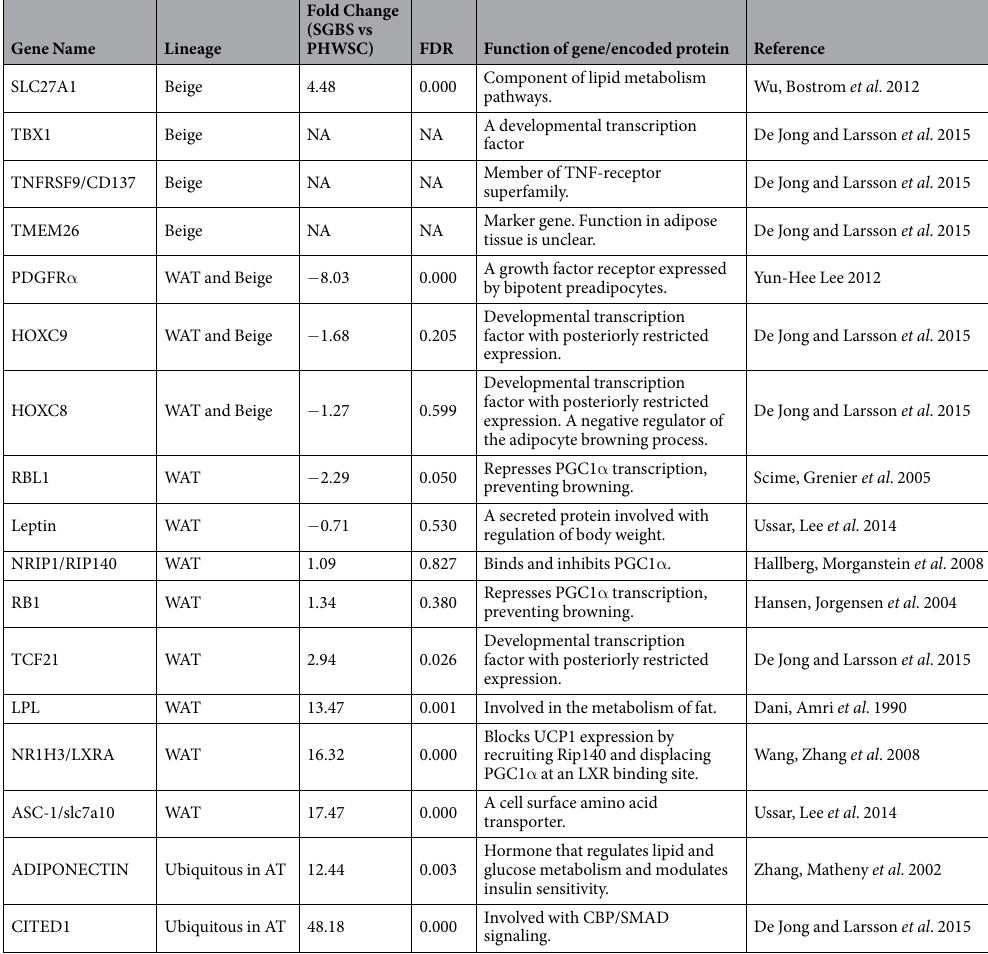
Table 2. List of adipocyte and adipose tissue lineage markers analysed in SGBS adipocytes compared to PHWSC adipocytes. Genes were pooled from published literature and their expression was analysed in the RNA sequencing